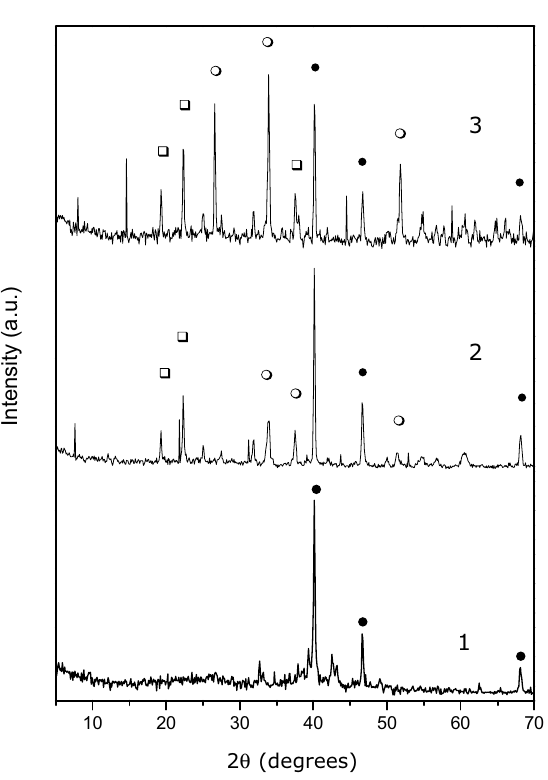
Fig. 2 – X-ray diffractograms of the decomposition products after heating compounds 1-3 at 1000 ◦ C. Assignments over the peaks refer to the phases: • = Pd, O = SnO 2 , (cid:1) = SnP 2 O 7